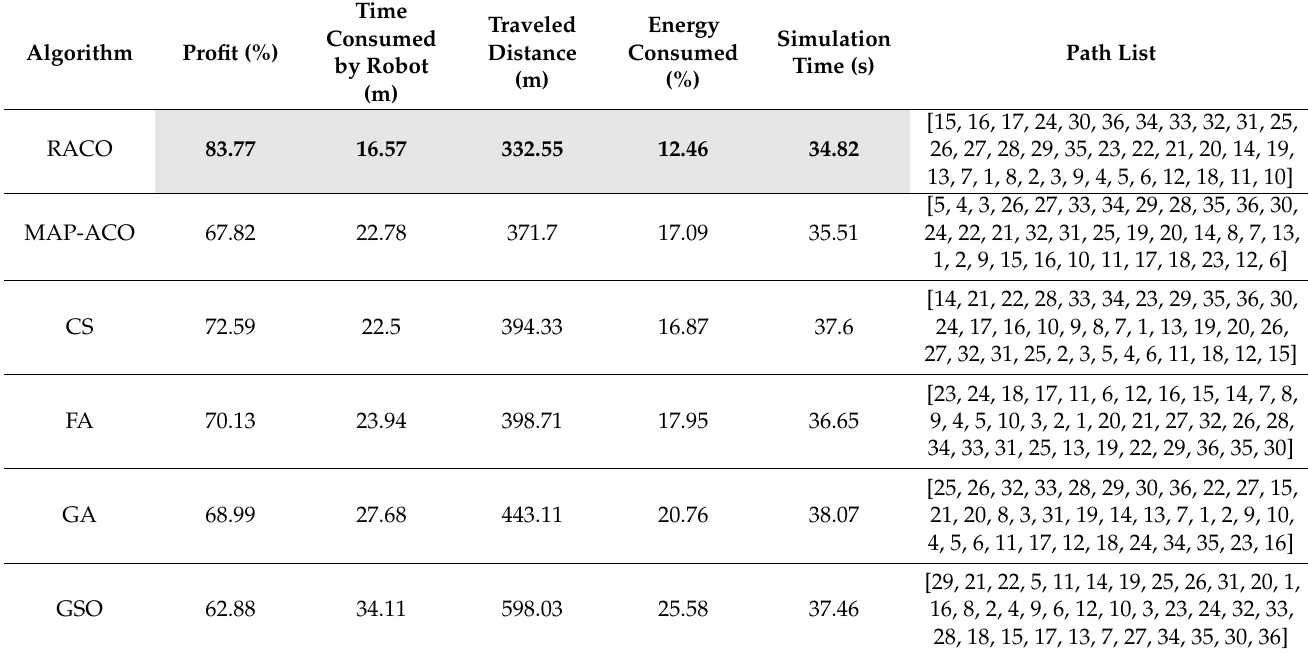
Table 5. The simulation results of each algorithm (best) based on all phases.